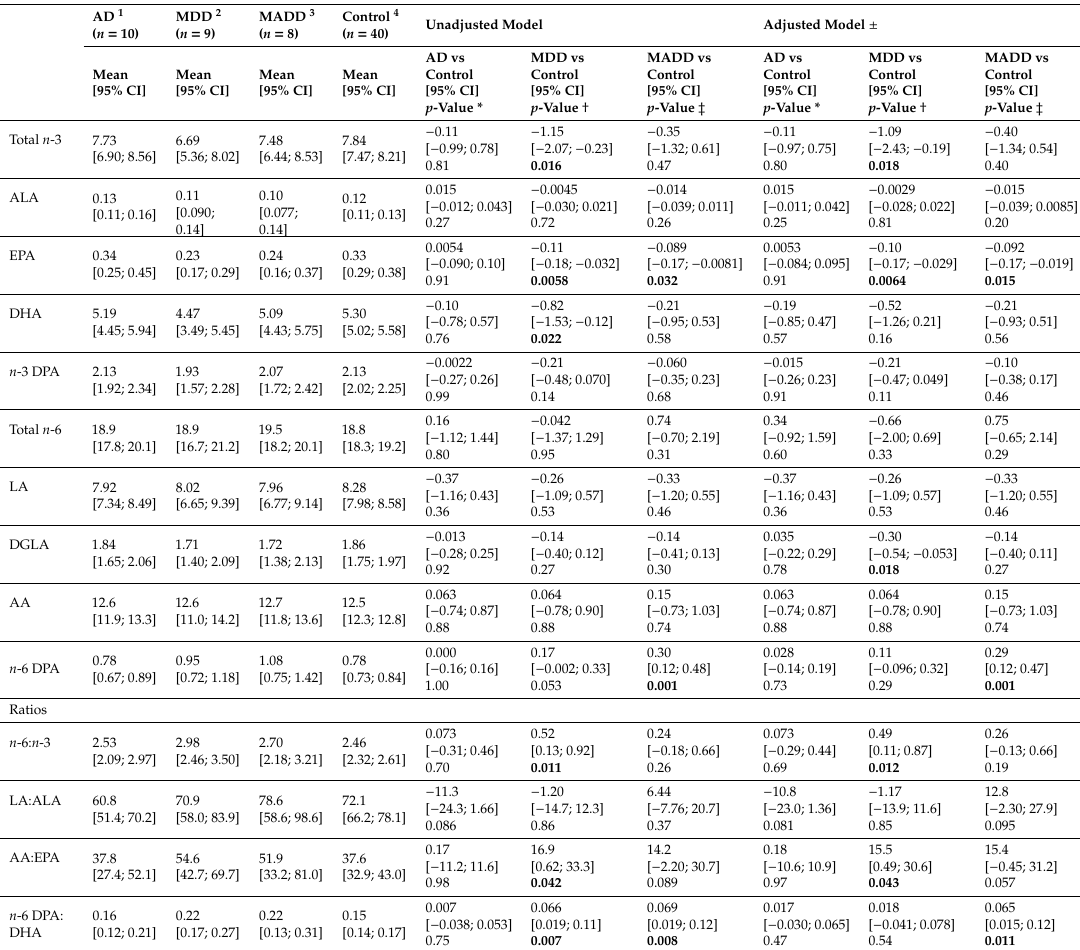
1 Anxiety disorder; 2 Major depression; 3 Co-morbid condition of major depression and anxiety disorder; 4 Healthy control group; * Contrast [95% CI] and p -value between AD and Control; † Contrast [95% CI] and p -value between MDD and Control; ‡ Contrast [95% CI] and p -value between MADD and Control; ± Covariates in adjusted models were selected using a significance level of p < 0.10 for inclusion and a significance level of p < 0.05 for retention in the final model. p -values < 0.05 are bolded. Abbreviations used: Total n -3, total omega-3 long-chain polyunsaturated fatty acids; ALA, alpha-linolenic acid; EPA, eicosapentaenoic acid; DHA, docosahexaenoic acid; n -3 DPA, n -3 docosapentaenoic acid; Total n -6, total omega-6 long-chain polyunsaturated fatty acids; LA, linoleic acid;